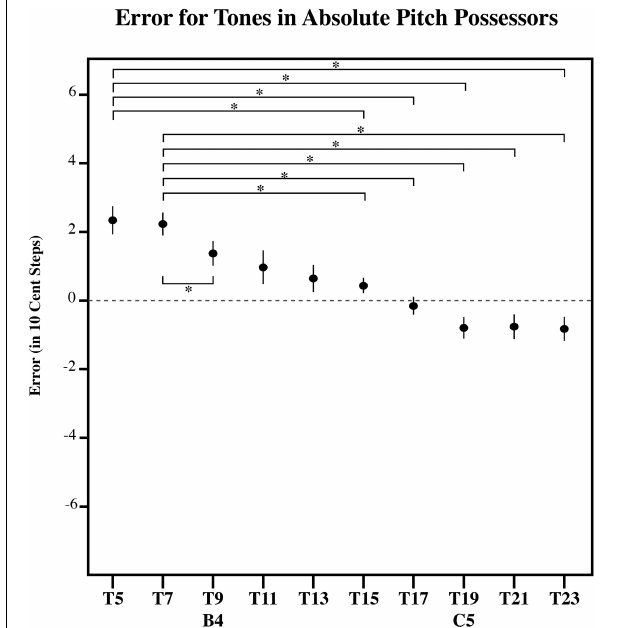
FIGURE 8 | The error in 10-cent steps for each tone in AP possessors. Significant pairwise comparisons (alpha 0.05) using a Sidak adjustment are indicated with an asterisk. Note that AP possessors bisect the presented distribution at its midpoint, such that lower tones in the series are overestimated and higher tones in the series are underestimated. However, note that this point for is closer to [C5] in AP possessors, than in ME ( Figure 9 ), MN ( Figure 10 ), and the RGD ( Figure 11 ). Additionally, AP possessors ( Figure 8 ) and ME ( Figure 9 ), have flatter error patterns than MN and the RGD ( Figures 10 , 11 ). Error bars represent ± 1